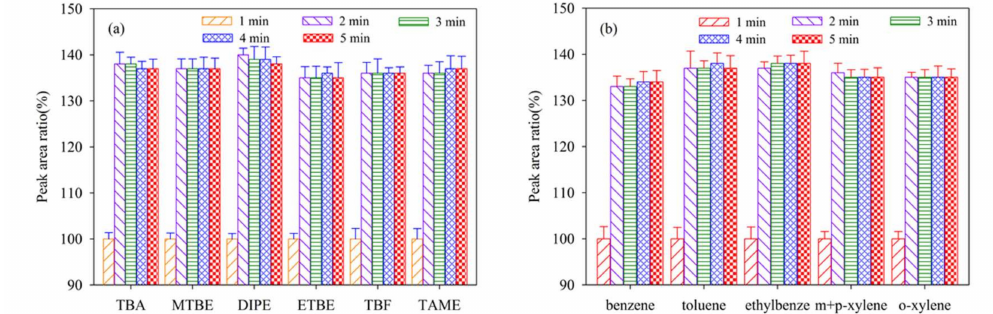
Figure 3. E ff ect of desorb time on signal intensities of the twelve analytes (20 µ g / L). The peak area at the desorb time of 1 min is used as a reference (100%). ( a ) the peak area ratio of TBA, MTBE, DIPE, ETBE, TBF, and TAME; ( b ) the peak area ratio of benzene, toluene, ethylbenze, m + p–xylene, and o–xylene.